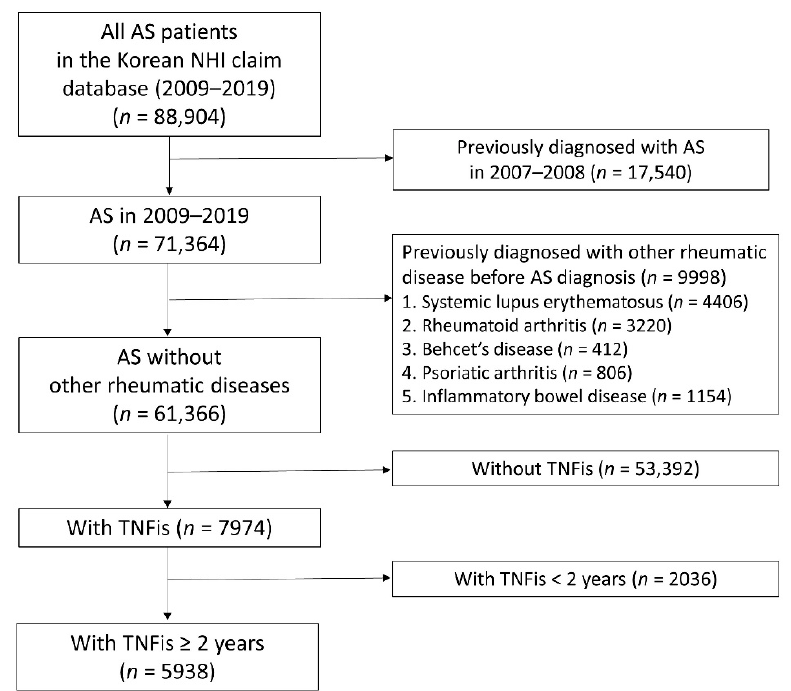
Figure 1. Selection of the study population. AS: ankylosing spondylitis, NHI: National Health Insurance, TNFis: tumor necrosis factor-alpha inhibitors. Table 1. Baseline characteristics of TNF- α inhibitor